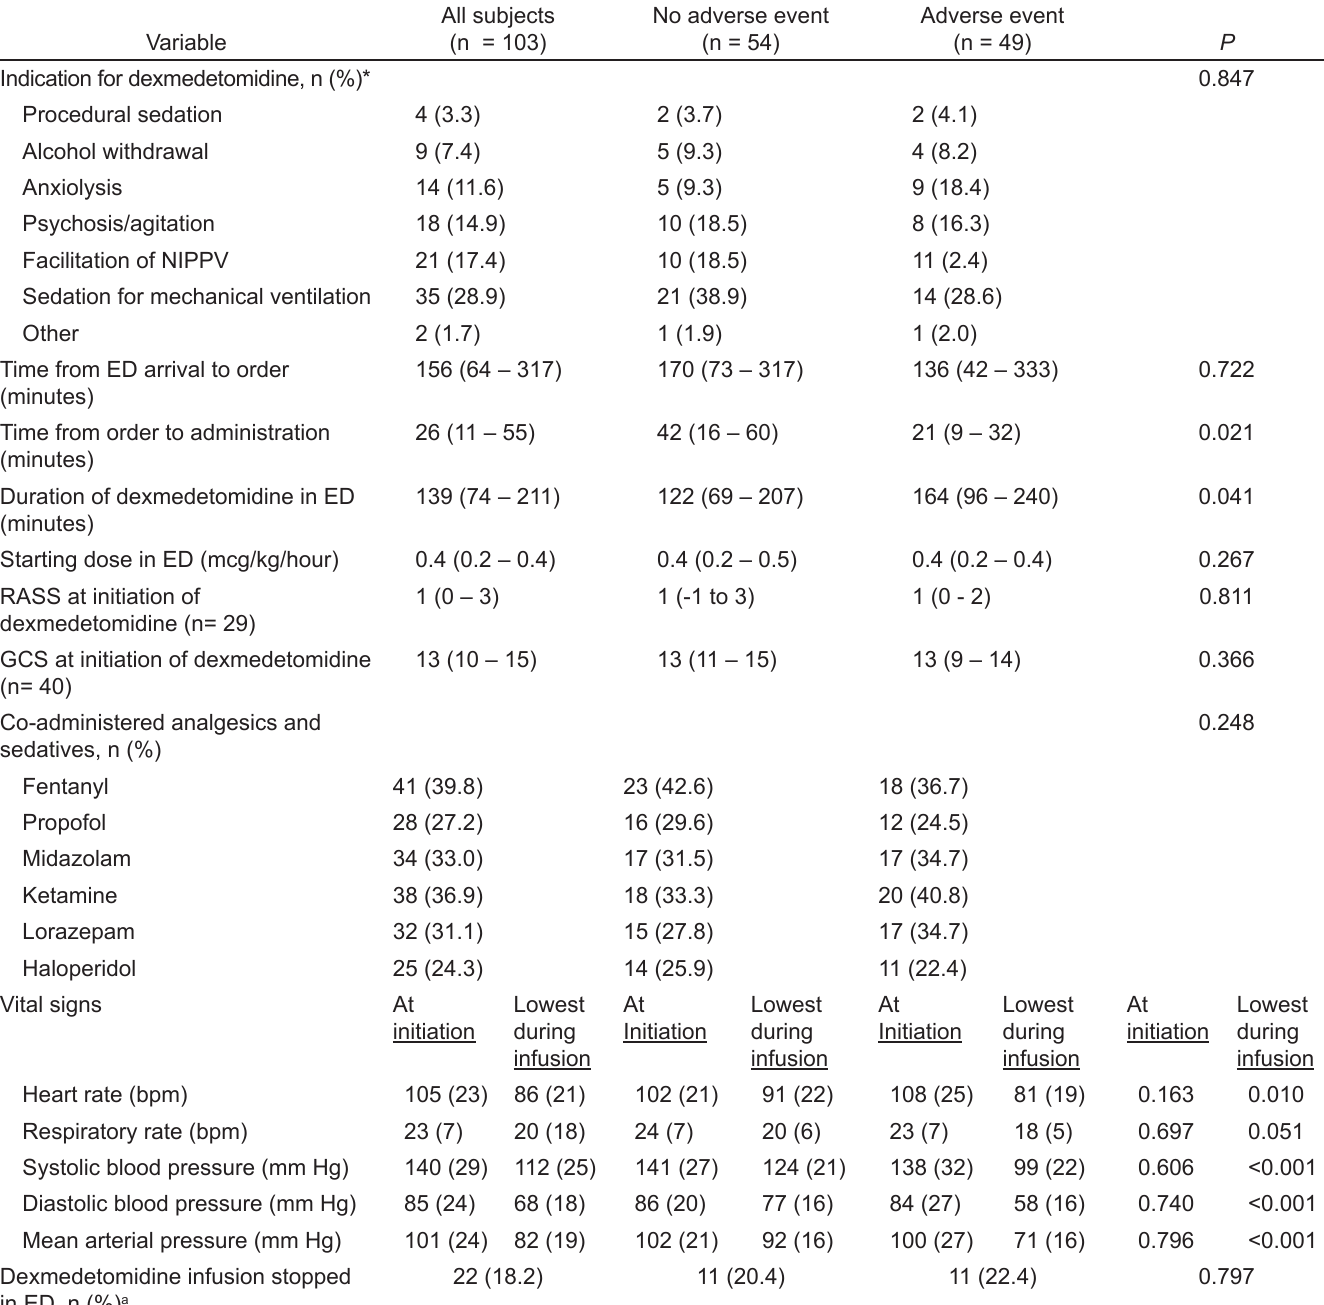
Table 2. Dexmedetomidine dosing and sedation characteristics.